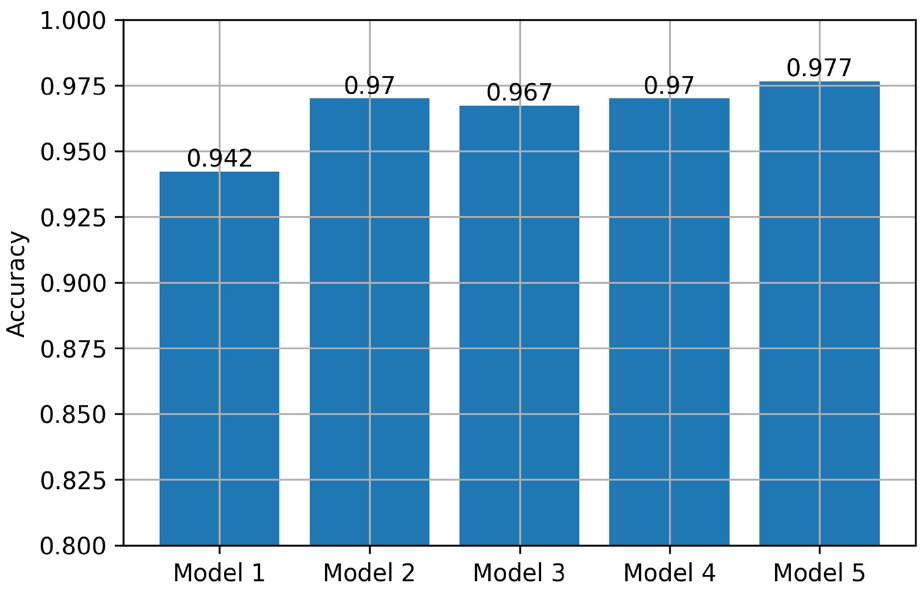
Figure 13. Learning curves of a VGG16 model with data augmentation. 3.2.2. VGG19 VGG19 exhibited a slightly poorer performance than GG16. The simplest classifier yielded the lowest accuracy, while the rest performed similarly (Figure 14).